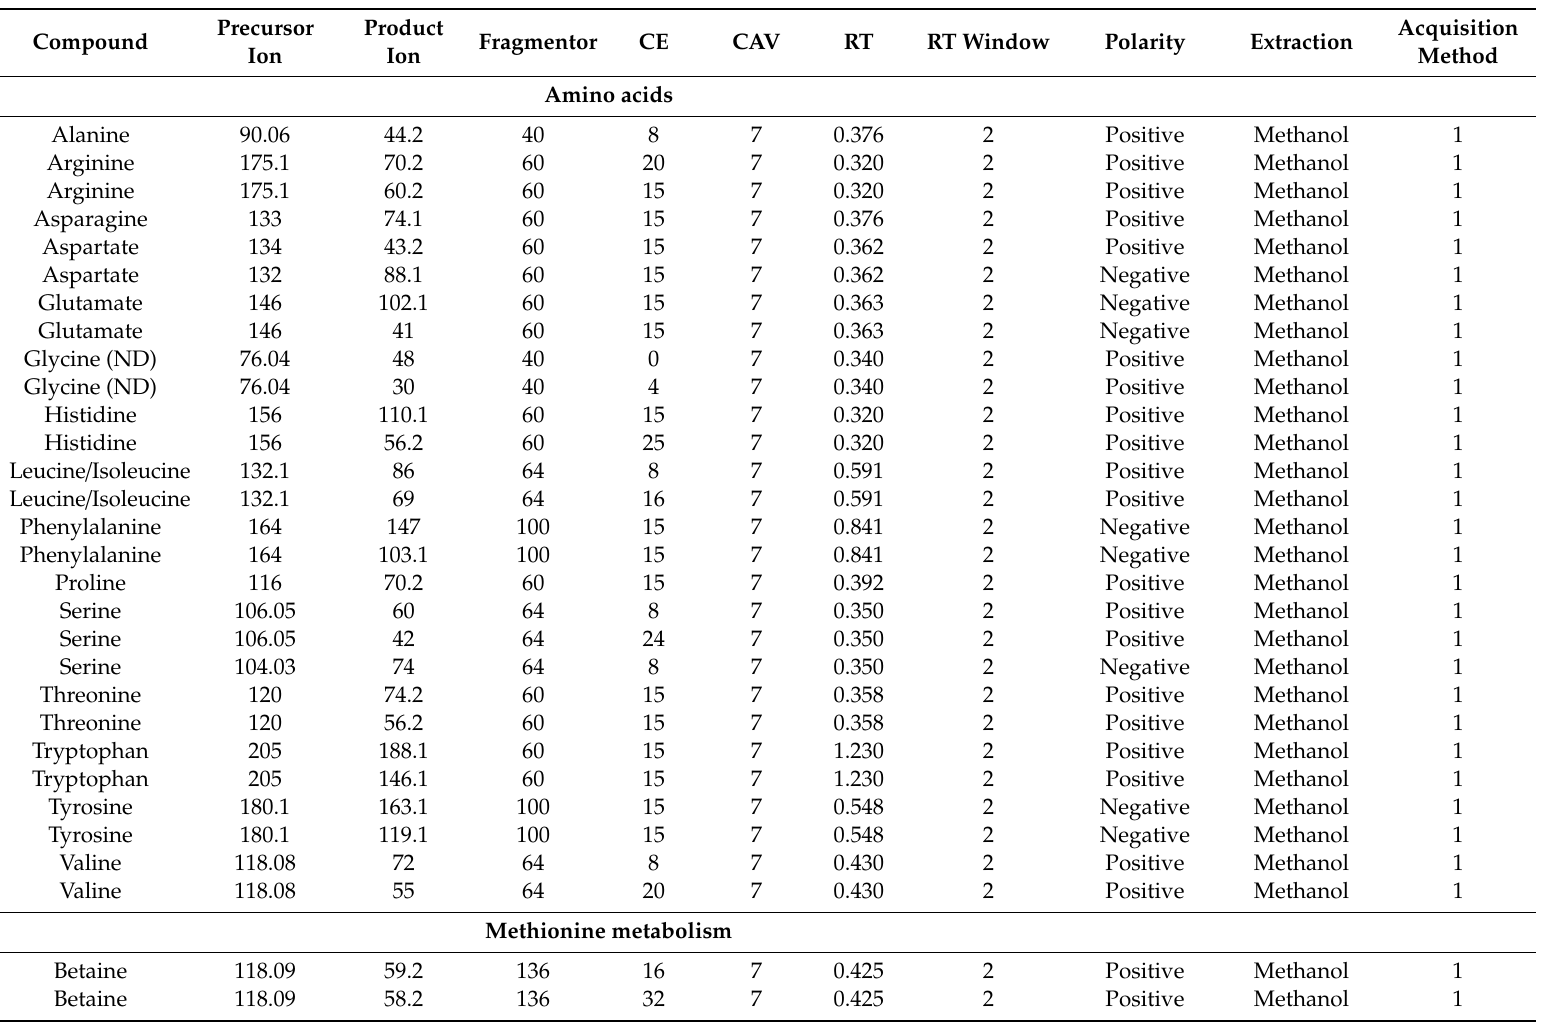
Table 1. Analytical traits of the metabolites measured in